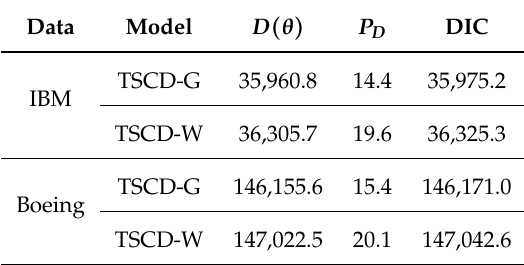
Table 4. Model selection by using the observed-data DIC